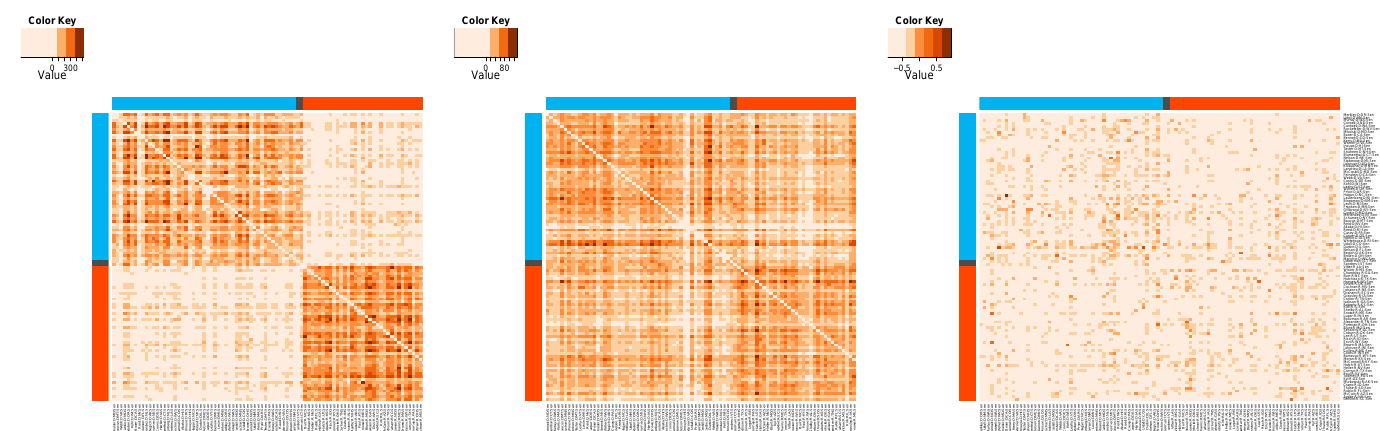
Figure 5. The matrices of the three different social networks extracted from the dataset: (a) Joint Authoring, (b) Infection Sharing and (c) Infection Following networks. Rows and columns in the matrices are reshuffled according to party and connections. The colors around the rows and columns indicate the party affiliation (Republican: red; Democrat: